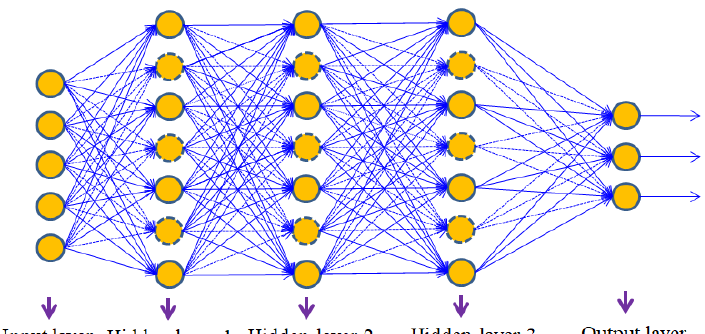
Figure 5. ReLU function.